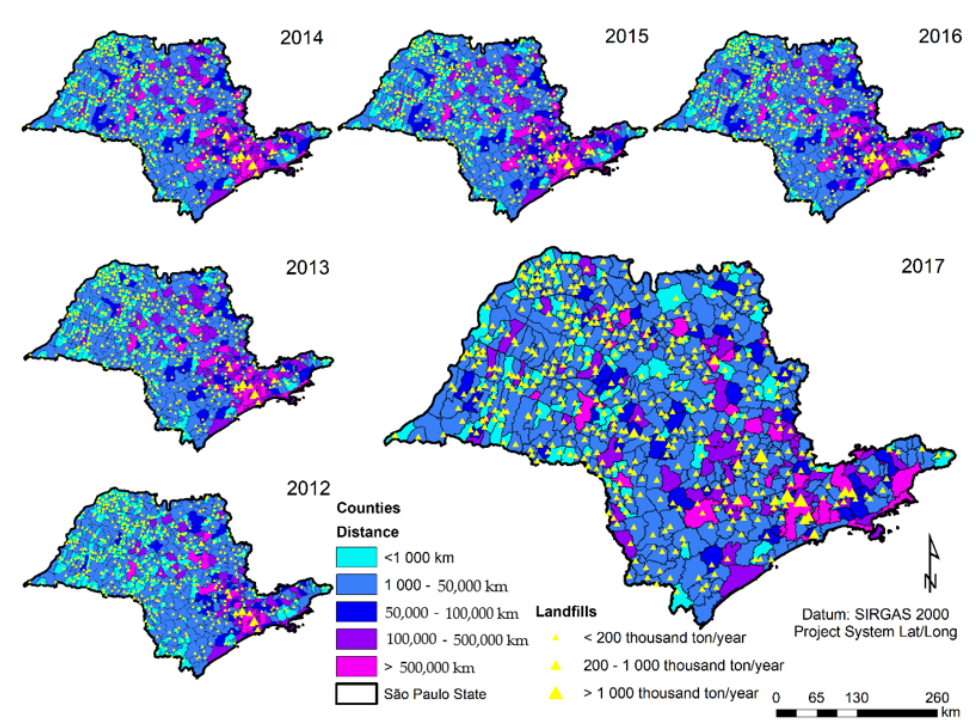
Figure 5. Sao Paulo state's municipalities classification according to the total distances covered by MSW truck's vehicles from 2012 to 2017.